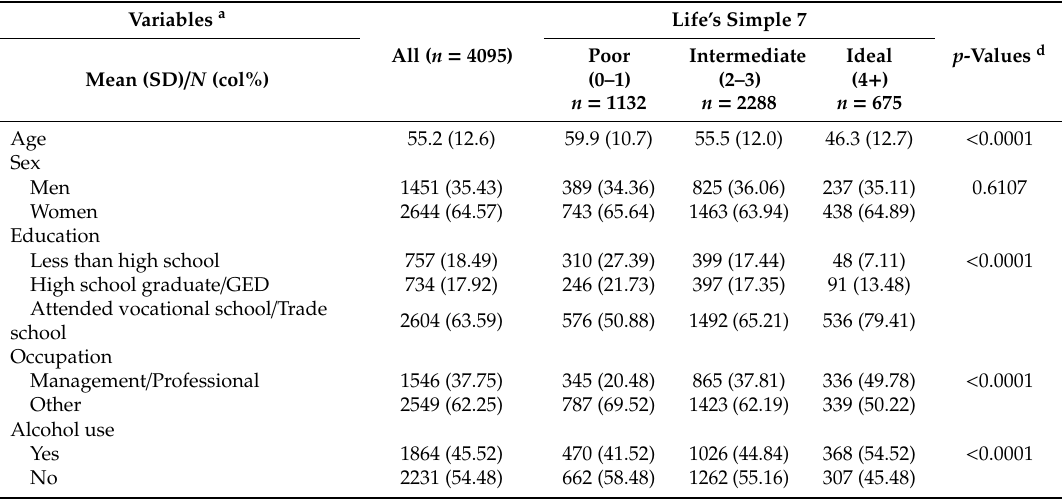
Table 1. Baseline